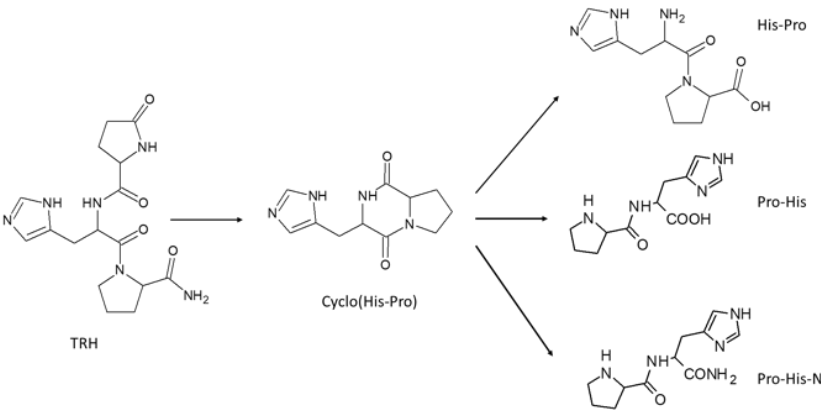
Figure 1. Molecular structure of the studied peptides with the involved biochemical reactions (enzymes or reagents are not reported for clarity).